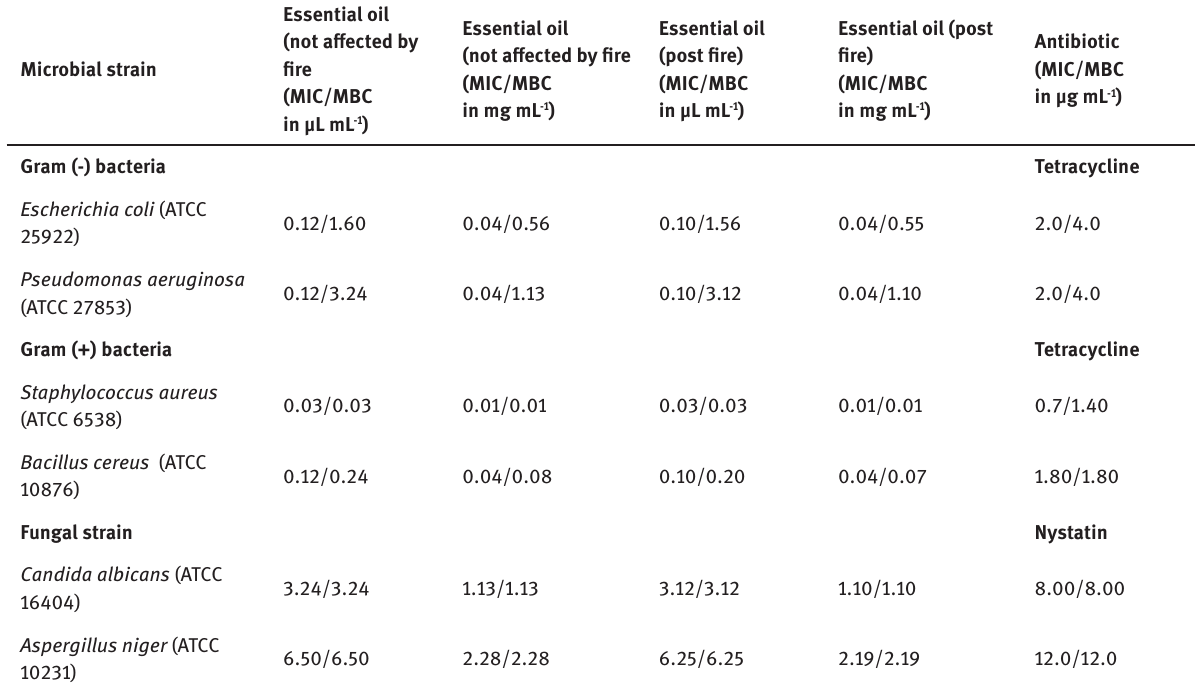
Table 2: Antimicrobial activities of S. rigidum fruit essential oils.